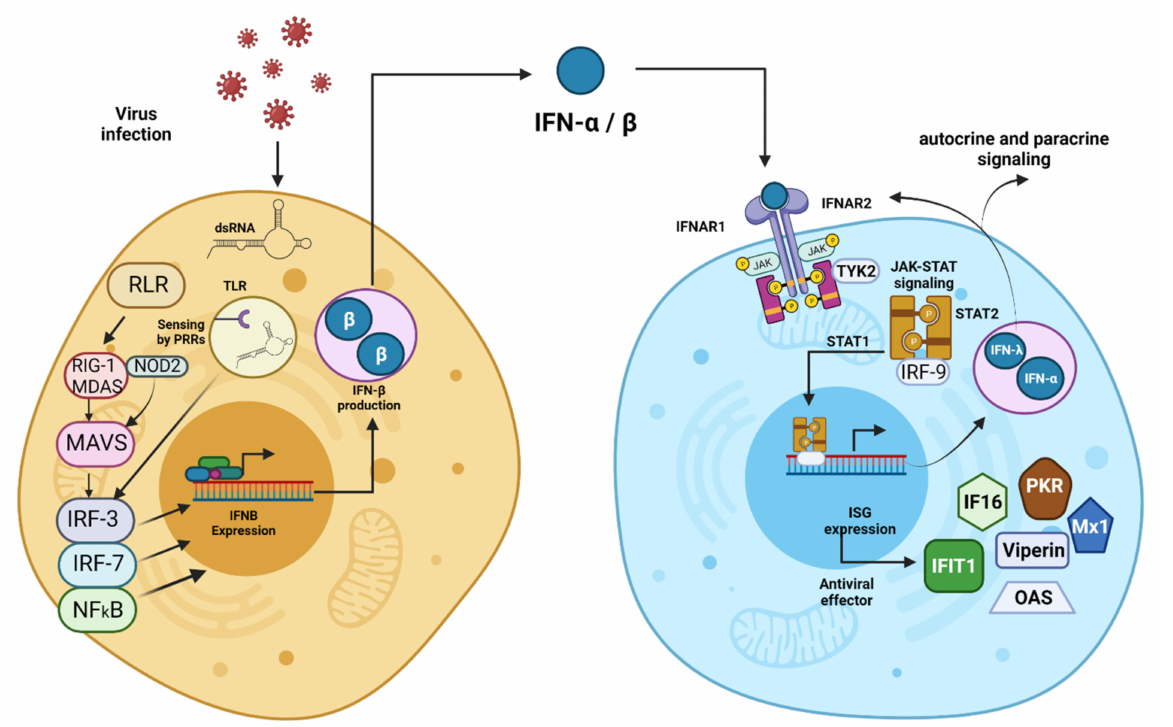
Figure 1. Type I Interferons Induction and Functions. Type I IFNs are first induced intrinsically in infected cells through a process of host cell recognition of segments of DNA or RNA or other viral macromolecules called pathogen-associated molecular patterns (PAMPs). PAMPs recognition as non-self-starts with their binding to specific cellular pathogen recogni- tion receptors (PRRs), such as Toll-like receptors (TLRs), RIG-I-like receptors (RLRs), NOD-like receptors. Receptor-ligand binding triggers the type I IFN induction cascade via NF κ ß, resulting in the activation and translocation to the nucleus of IFN regulatory factors IRF3 and IRF7, which induce the expression of type I IFNs. The expressed cytokine is exported to the extracellular milieu and binds to IFNAR, a heterodimeric receptor consisting of two subunits, IFNAR1 and IFNAR2. The molecule forms a trimeric structure with the receptor, thus activating the proteins Janus kinase 1 (JAK1) and tyrosine kinase 2 (TYK2). These proteins activate the signal transducers and activators of transcription 1 and 2 (STAT1 and STAT2), which induce the transcription of interferon-stimulated genes (ISGs) by forming a complex with IRF9. These ISGs encode antiviral effectors (PKR, Mx1, OAS, etc.) and activate type I IFN production, thus triggering autocrine and paracrine signaling. Cells from the innate immune system, such as dendritic cells (DCs) and macrophages, produce type I IFN after sensing pathogen components using various PRRs found on the plasma membrane, in endosomes, and throughout the cytosol. Created with